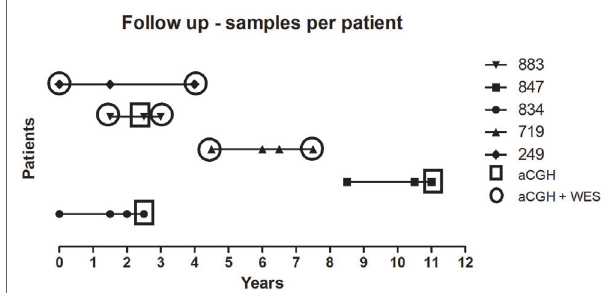
FigUre 1 | Longitudinal analysis of uniformly treated MPN cases. Five cases were analyzed by aCGH and WES before and after therapy. The horizontal axis represents the timeline (in years) of sample collection. Each case is presented in the right legend. Squares are showing samples analyzed only by aCGH and circles by the two methodologies applied. aCGH, array-based comparative genomic hybridization; MPN, myeloproliferative neoplasm; WES, whole exome